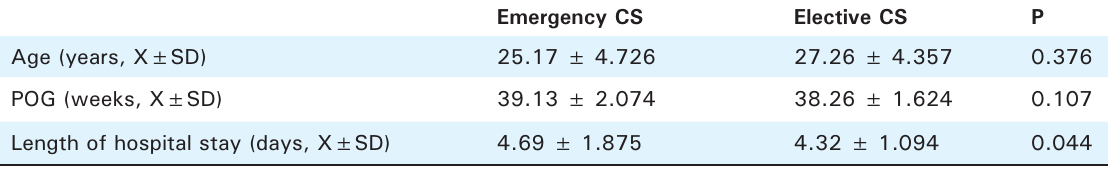
Table 2. Age, period of gestation, length of hospital stay in studied women.